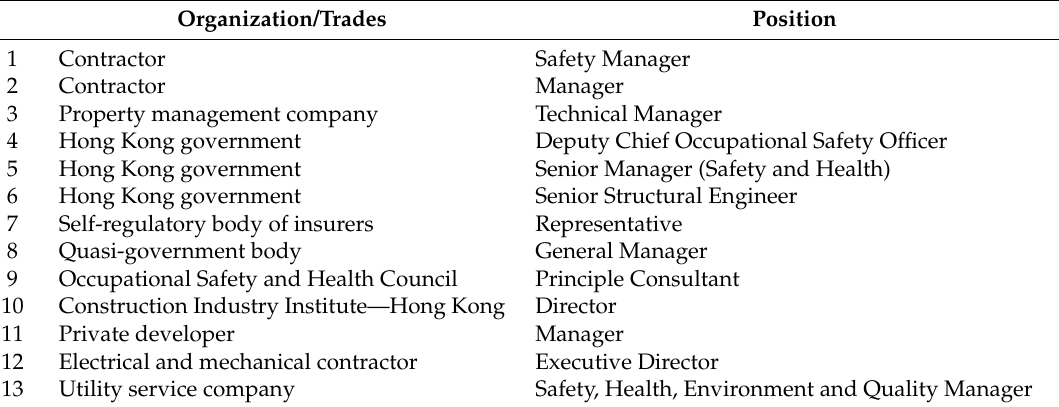
Table 1. Background information of the thirteen